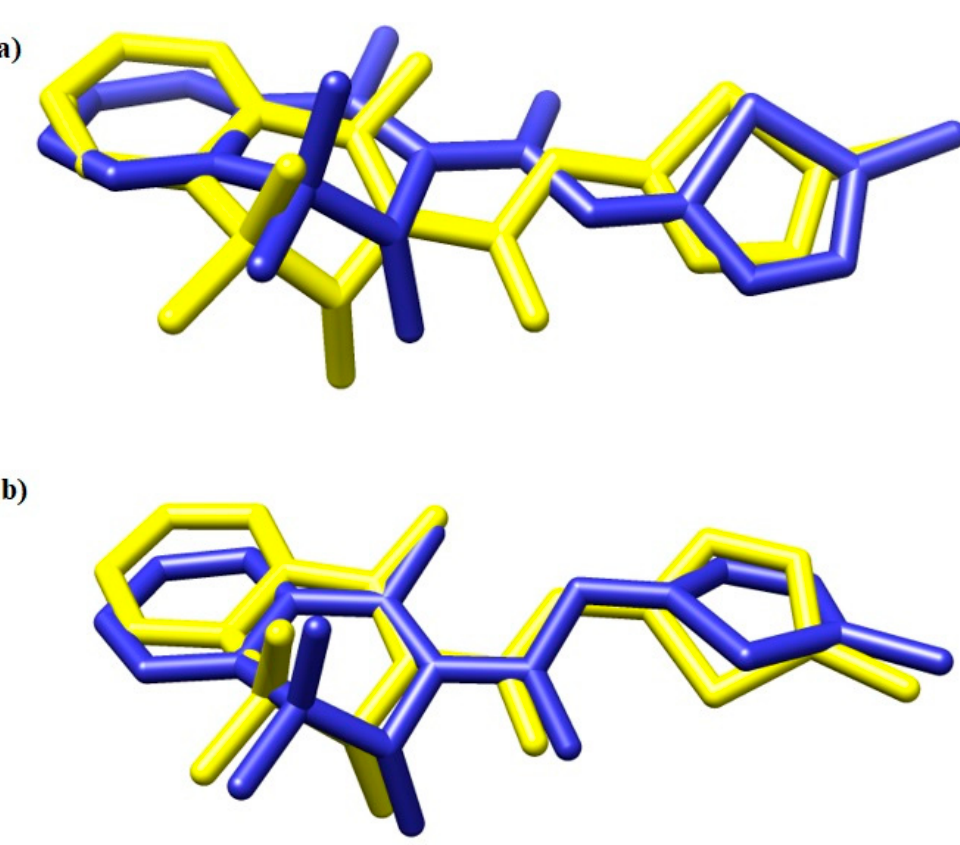
Figure 7. The overlay of meloxicam conformation in ( a ) 4M11 and ( b ) 4O1Z co-crystal ( yellow ) and the best docked conformer ( blue ) [53]. Table 2. Binding energies to COX-1 and COX-2 of the most active anti-COX compounds ( TG4 , TG6 , and TG10-TG12)